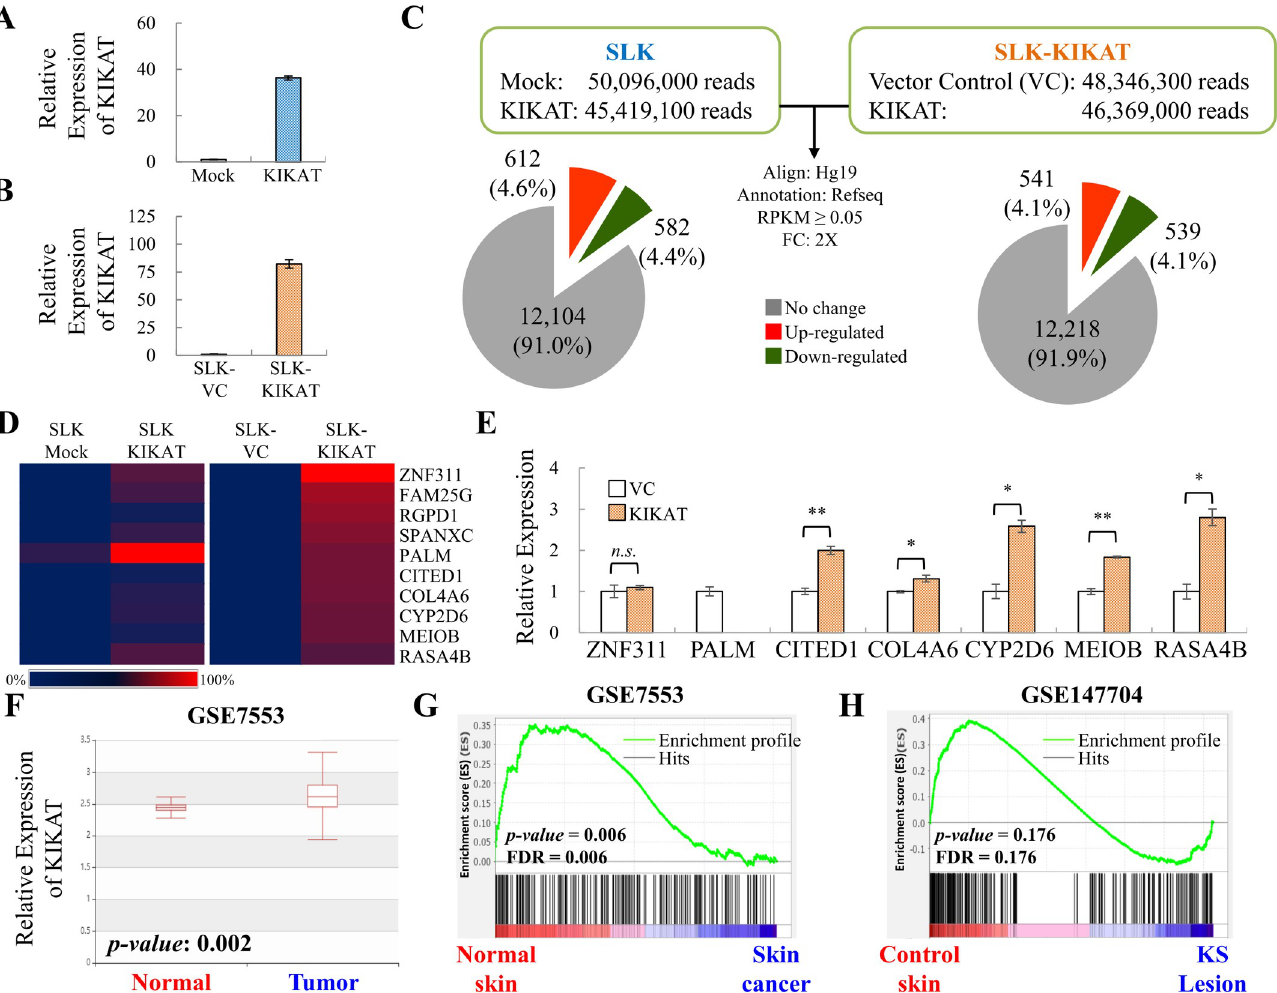
Fig 3. RNA-Seq analysis revealed that KIKAT/LINC01061 may function as an onco-lncRNA. (A) RT-qPCR analysis of KIKAT/LINC01061 expression in SLK cells transiently transduced with lentivirus expressing KIKAT/LINC01061 or with no cDNA (mock). (B) RT-qPCR analysis of KIKAT/LINC01061 expression in a stable SLK cell line overexpressing KIKAT/LINC01061, SLK-KIKAT/LINC01061, and its vector control cells, SLK-VC. (C) RNA-seq was performed using total RNA isolated from cells in (A) and (B). Paired-end raw reads were aligned and annotated as described in Fig 1A. RPKM � 0.05 in at least one condition was considered as expressed and used for further analysis. Pie chart showing the numbers (percentages) of mRNAs that were up- or down-regulated more than 2-fold in transient transduced cells (Left) and stable cell lines (Right). (D) Expression heatmap of top 10 up-regulated genes of RNA-seq data from both transient (left) and stable (right) KIKAT/LINC01061 expression SLK cells. (E) RT-qPCR analysis of the expression of top 10 up-regulated genes identified in (D) in SLK-KIKAT/ LINC01061 and SLK-VC cells. (F) KIKAT/LINC01061 levels in skin cancer and normal tissues were obtained from the human cancer metastasis database (HCMDB). The statistical significance was calculated using student’s t -test. (G and H) GSEA analysis reveal the correlation of KIKAT/LINC01061 down-regulated genes ( � 5-fold) with skin cancer (GSE7553) (G) and Kaposi’s sarcoma (KS) lesion (GSE147704) (H). Significance was determined by student’s t -test. � p < 0.05, �� p < 0.01, n . s .